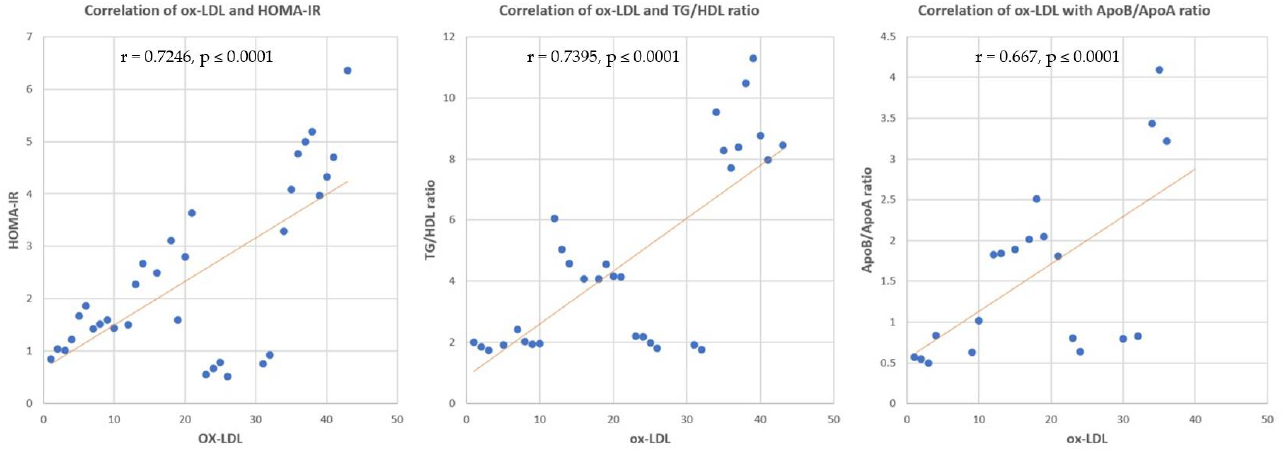
Figure 9. Correlation of ox-LDL and HOMA-IR, TG/HDL ratio, and Apo B/Apo A ratio. r = correla- tion coefficient. p = value of statistical significance.